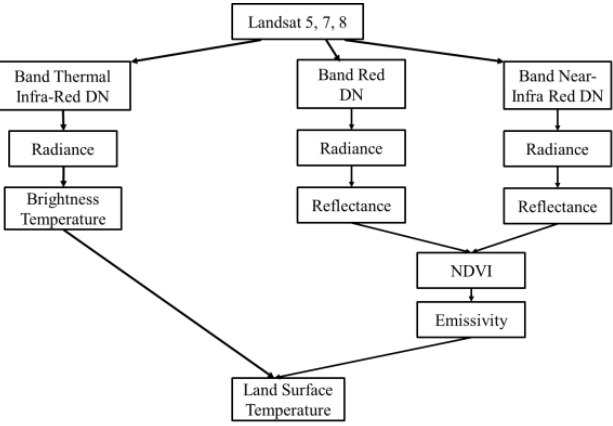
Figure 2. Flowchart of methodology used in obtaining Landsat derived variables—normalized difference vegetation index (NDVI), emissivity, and land surface temperature (LST) [39].